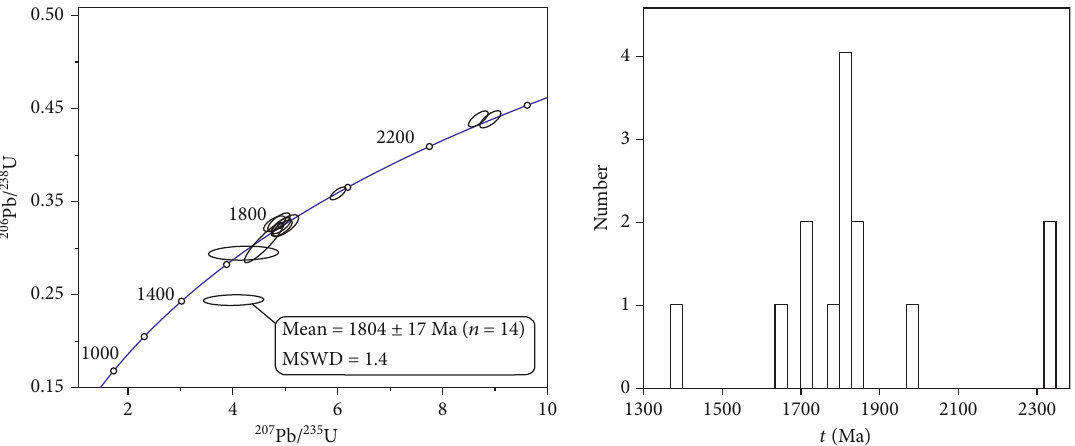
Figure 6: Zircon U-Pb age Concordia diagram and histogram of CM5.